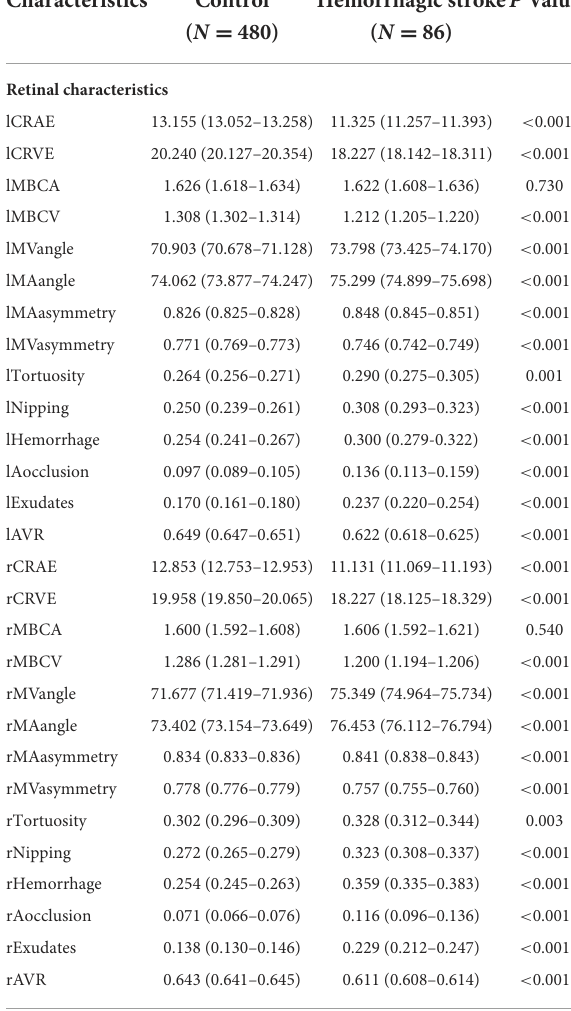
TABLE 3 Comparison of retinal characteristics between control and hemorrhagic stroke.